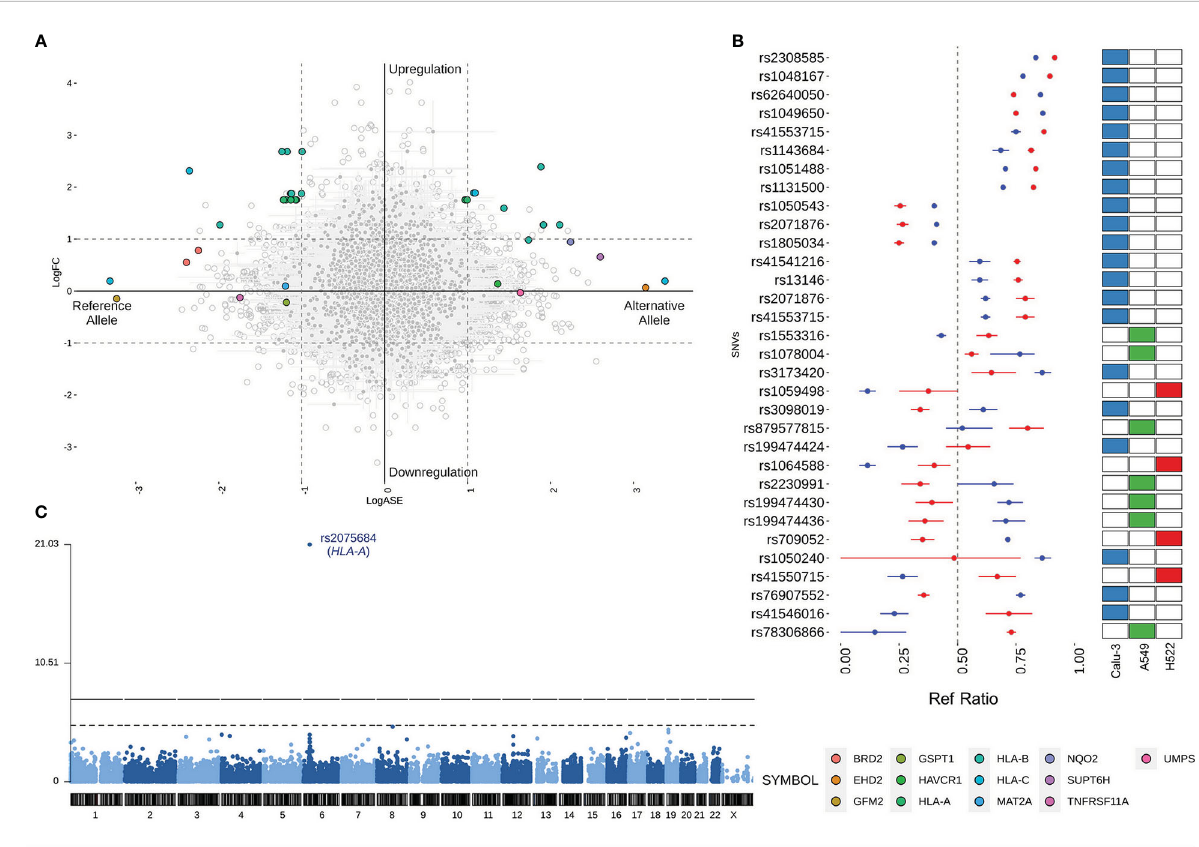
FIGURE 2 Comparison of the LogASE and LogFC from differential gene expression (DGE). (A) Plot showing the LogASE values for DASE sites on the x-axis and LogFC from the DGE comparing the infected with mock-treated cells. Positive LogASE values represent the increase of the alternative allele over the reference. In contrast, negative values represent ASE sites that exhibited a preferential expression of the reference allele after infection. Colored circles show the genes where each DASE site is mapped, whereas gray circles show the eSNVs that met the requirement of FDR > 10% in the DASE analysis. (B) Comparison between the Ref Ratio values of SARS-CoV-2 infected and mock-treated cells. The plot shows the ref ratio values on the x-axis and DASE sites on the y-axis. Red and blue circles represent the mean of Ref Ratio values among the replicates of SARS- CoV-2 infected and mock-treated cells, respectively. The interval bars denote the range between the min and max values found across the replicates. Ref Ratio values > 0.5 represent the preferential expression of the reference allele, whereas values < 0.5 show the bias towards the alternative allele. The heatmap at the right highlights the cell line where the DASE sites were found. (C) Manhattan plot showing the DASE sites found in iPSC-derived airway epithelium basal cells